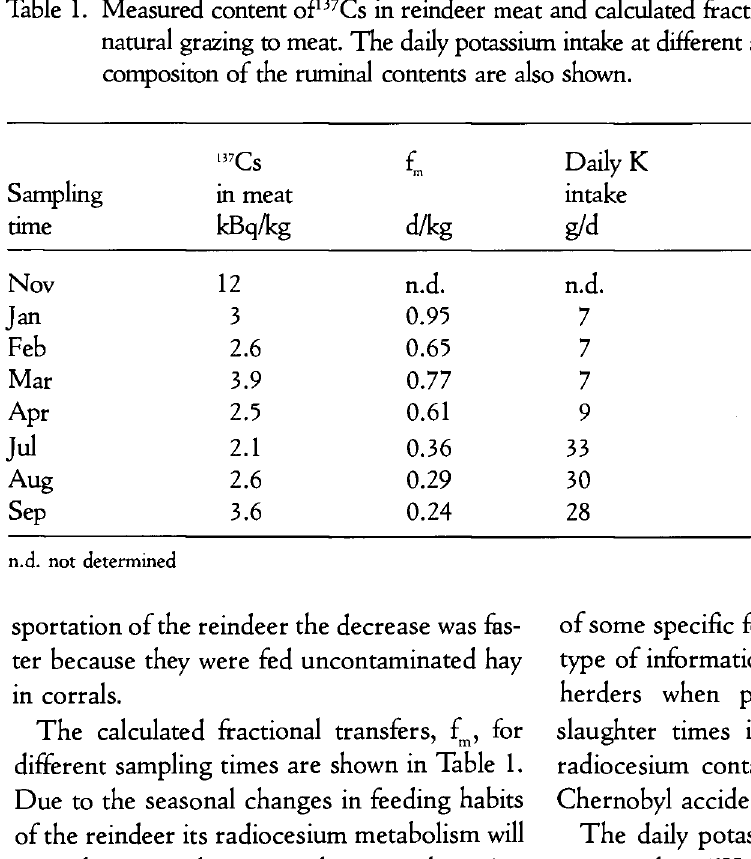
Table 1. Measured content of 137 Cs in reindeer meat and calculated fractional transfer, f , oF 37 Cs from natural grazing to meat. The daily potassium intake at different sampling times and the relative compositon of the ruminal contents are also